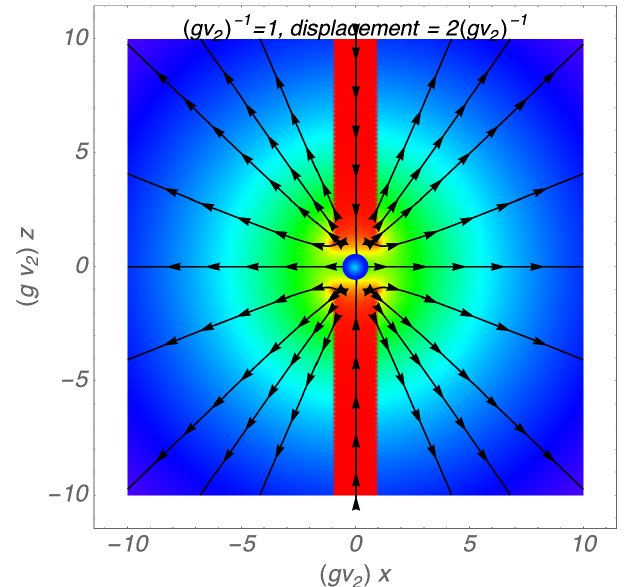
Figure 4 . The QED magnetic flux made by the QED fluxes confined in the dark cosmic strings. We approximate the configuration by the magnetic field made by two half infinite solenoids, which induces the spherical magnetic flux. The color density shows the absolute strength of the QED magnetic field. The strength decreases from red to blue in arbitrary unit. The monopole-like flux extends from the center of figure is induced not by the dark monopole but by the dark cosmic